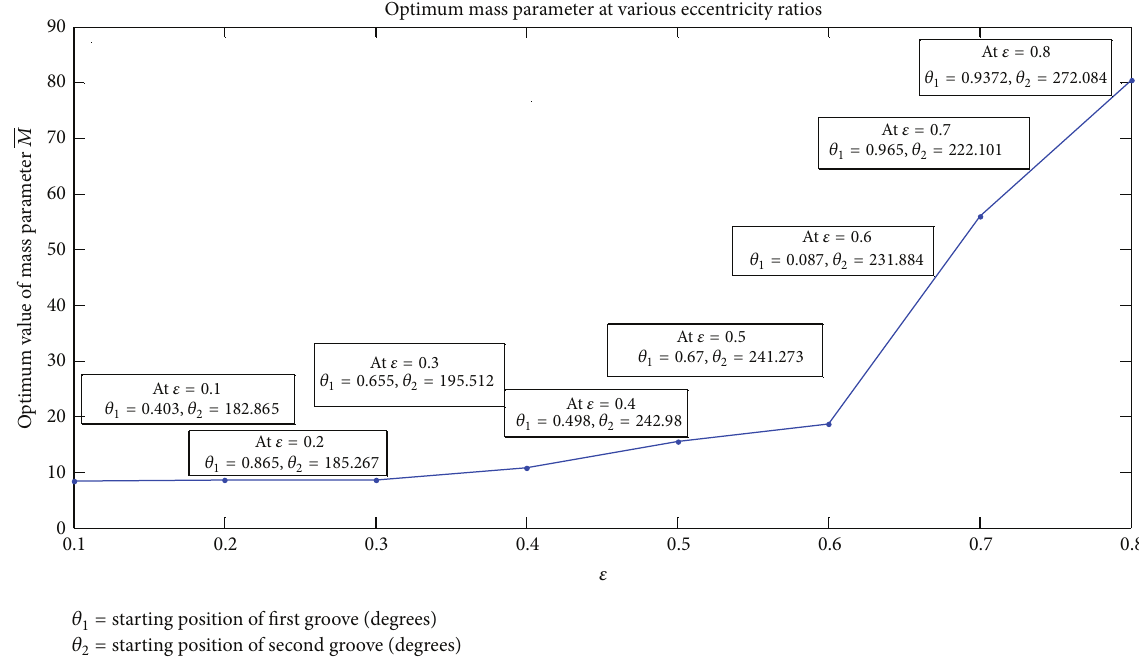
Figure 14: Variation of mass parameter at optimum grooving location for different eccentricity